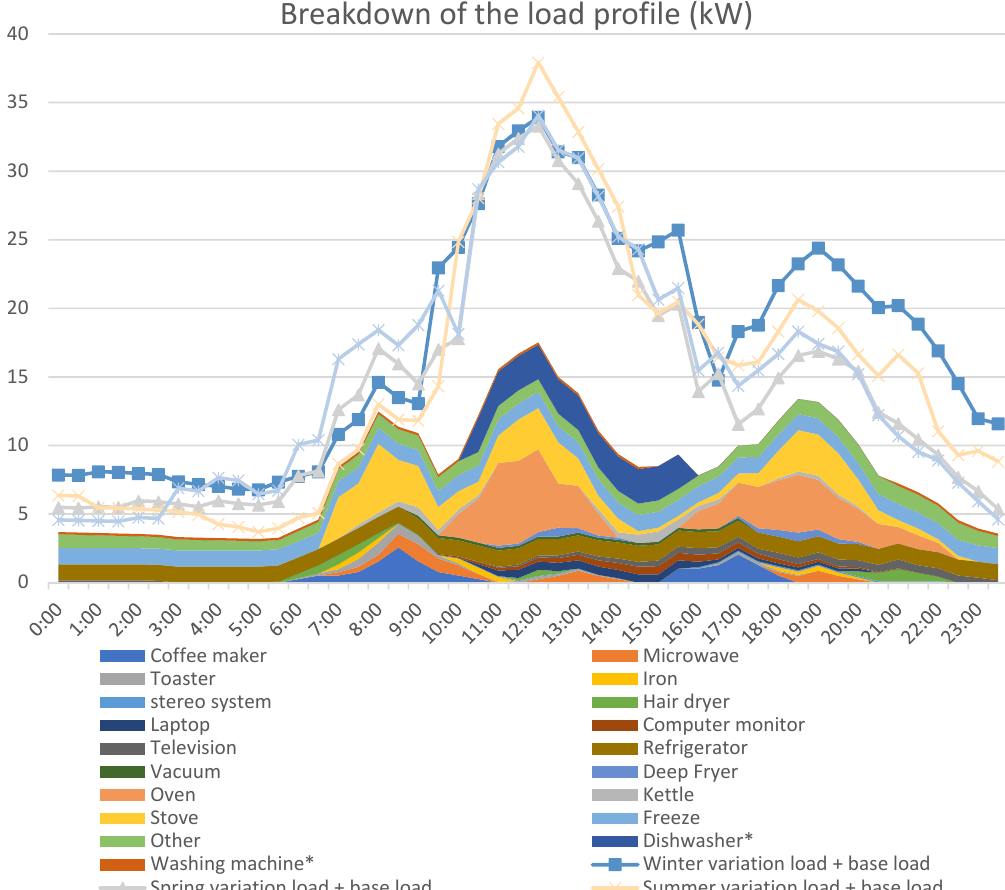
Figure 5. The simulated load profiles and the variations in different seasons.